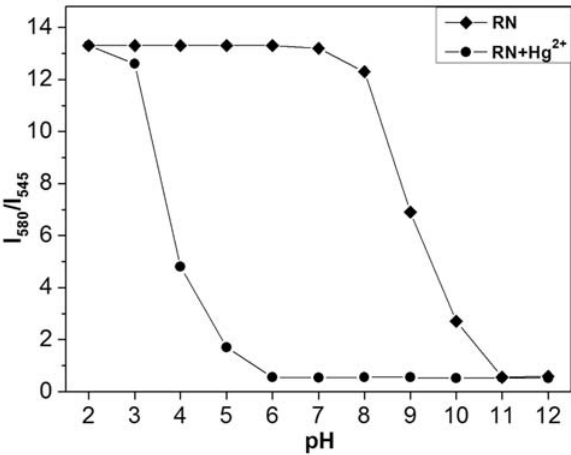
Figure 7. pH-dependent fluorescence intensity ratios of probe RD (10 μM) in the absence and presence of Hg 2+ (10 μM).